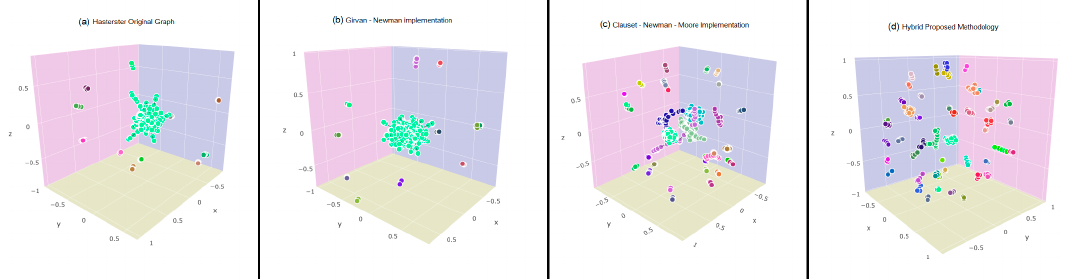
Figure 2. The graphical comparison of the different generated community structures for the Hamsterster social graph per each method applied: ( a ) The Hamsterster original graph visualization; ( b ) the Girvan–Newman generated community structure; ( c ) the Clauset–Newman–Moore generated community structure; and ( d ) the hybrid proposed methodology returned community structure.